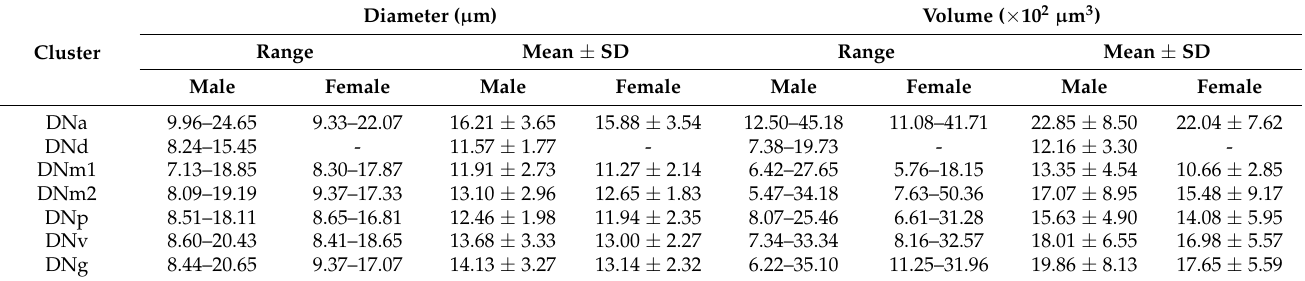
experiments, only one neck connective was labeled. “-” no data. Table 2. Diameter and volume of somata of descending neurons in the brain of Helicoverpa armigera